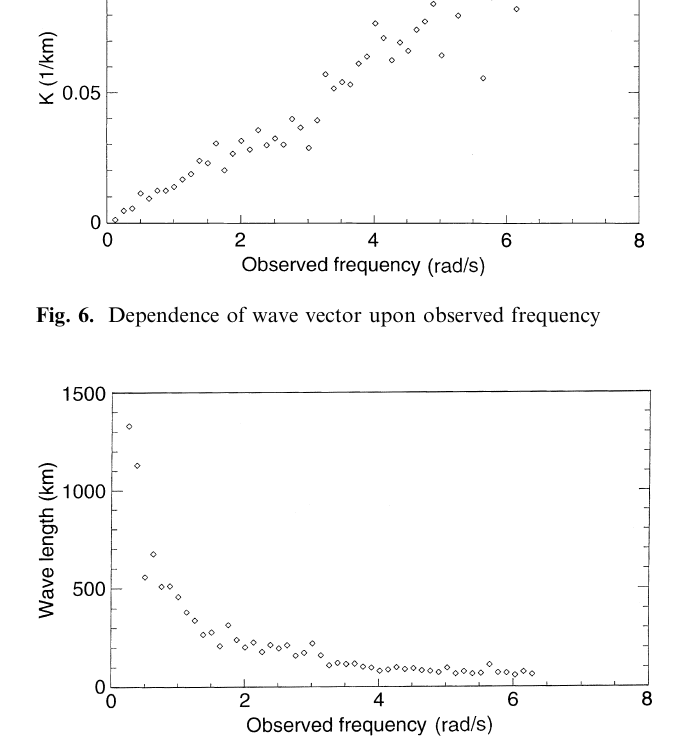
Fig. 7. Dependence of wave length upon observed frequency